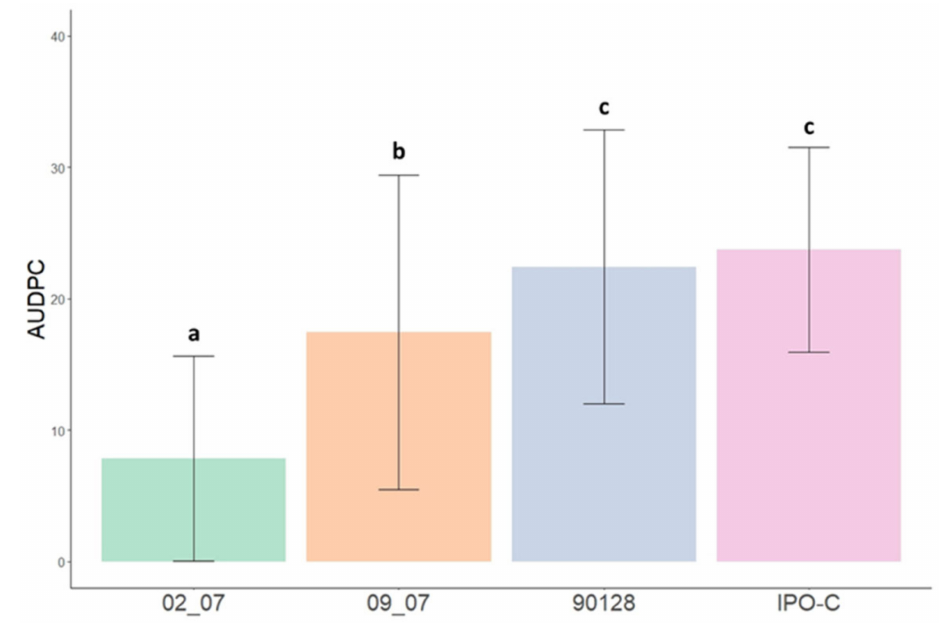
Figure 4. Area under the disease progression curve (AUDPC) values with standard deviation of each Phytophthora infestans isolates (02_07, 09_07, 90128, and IPO-C). ANOVA and Tukey’s analysis ( p < 0.05) were used to determine the level of aggressiveness of each isolate across all tested potato genotypes and parental cultivars ( n = 14). Same letters for individual P. infestans isolate indicate no statistical